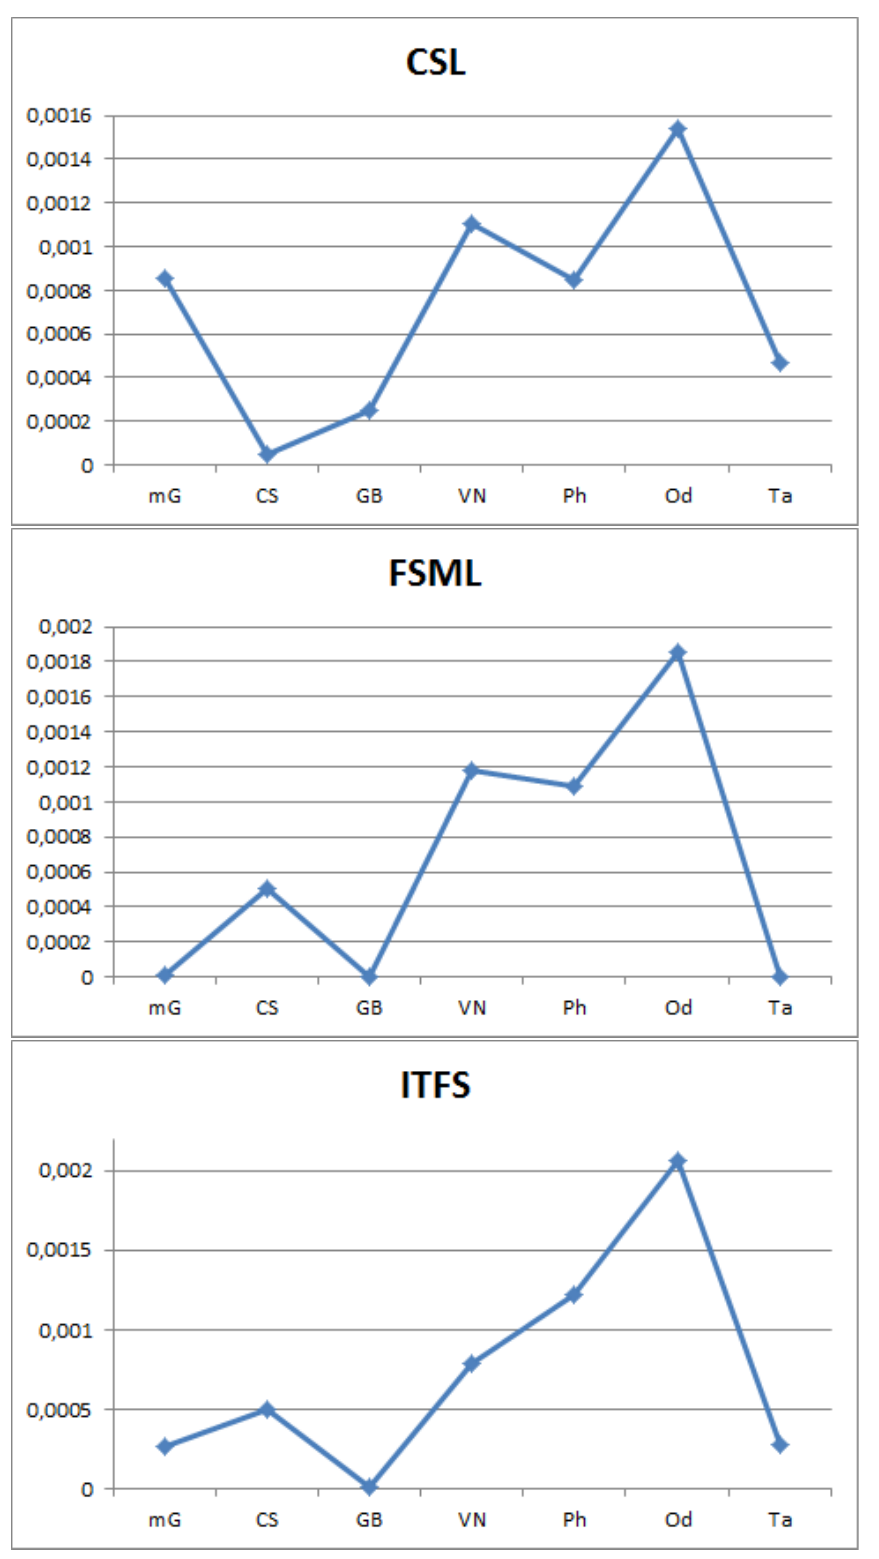
Figure 3: Mean values of CSL (top), FSML (center) and ITFS (bottom) N-gram features for the 7 class C GPCR